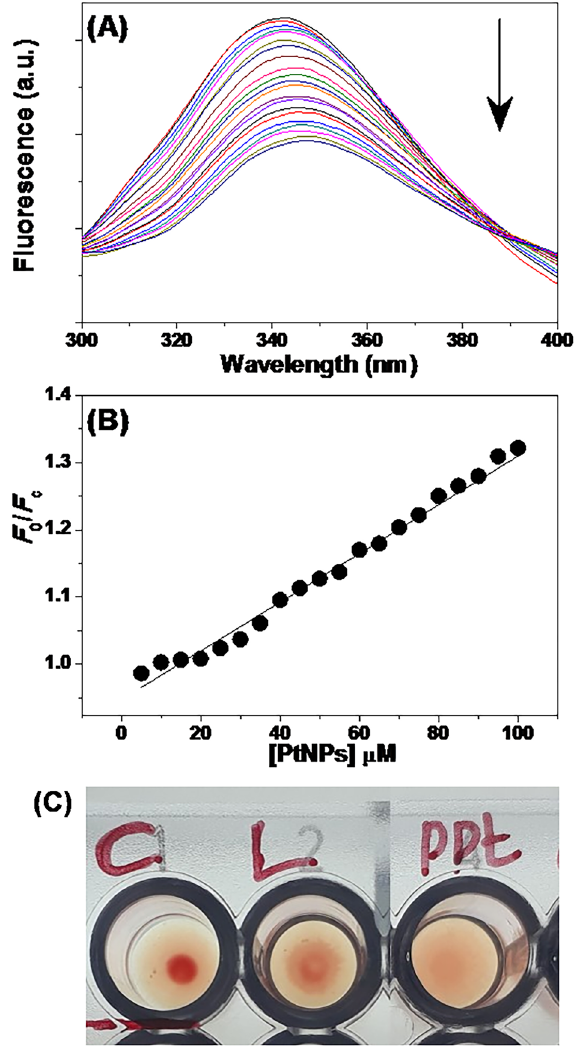
Figure 1. The fluorescence quenching study. ( A ) Fluorescence titration. The upper spectrum corresponds to the emission of Md-Lec alone and the remaining spectra depicts the decreasing fluorescence emission spectra with increase in the concentration of the PtNPs (0–100 µM) ( B ) Stern–Volmer plot. ( C ) Haemagglutination assay. C Control RBC, L Md-lec, PPt